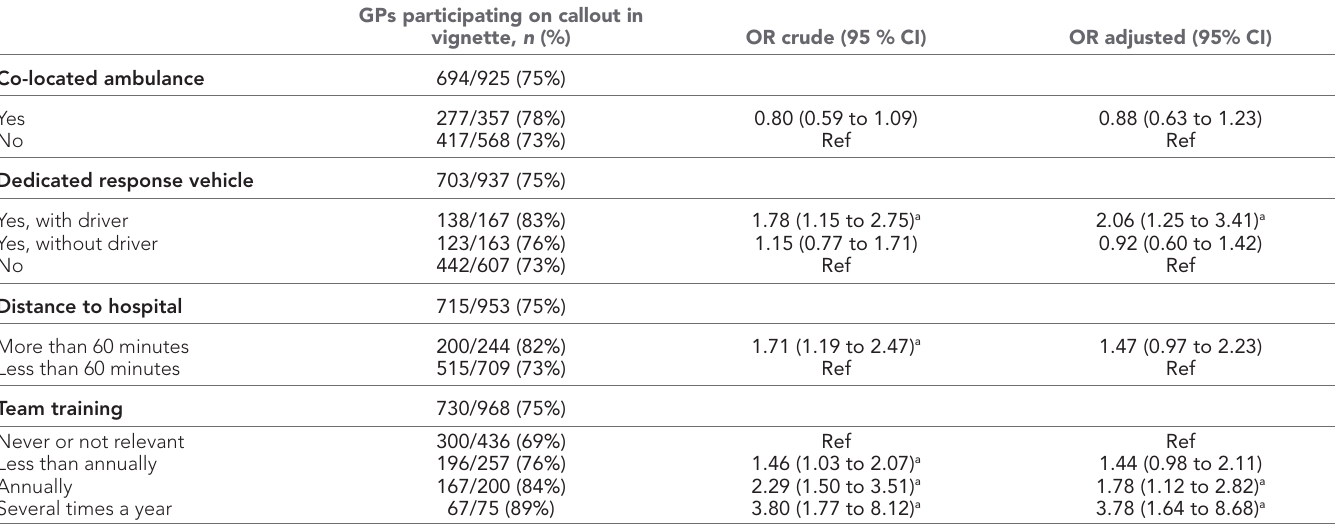
Table 5 Multivariable logistic regression analyses: associations between GPs participating on callout in vignettes and OOH clinic